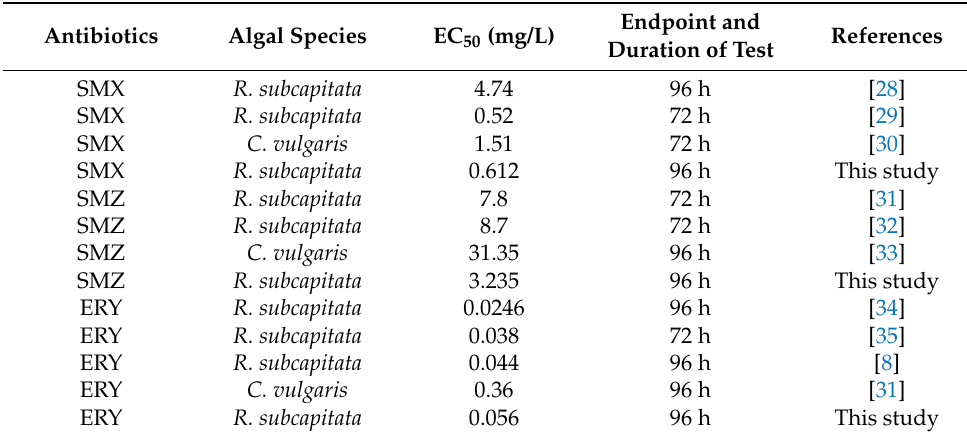
Table 1. The ecotoxicological effects of SMX, SMZ, and ERY on the growth inhibition of microalgae were summarized and contrasted with previously reported